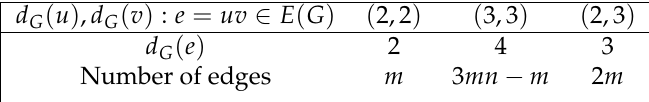
Table 3. Edge degree partition of TUAC 6 [ m , n ] .